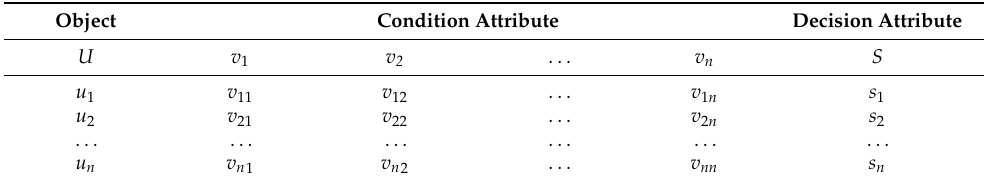
Table 2. The general form of the decision